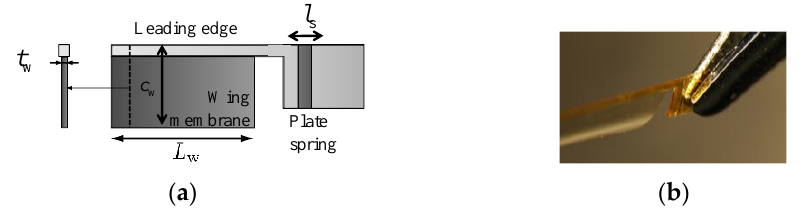
Figure 12. Detailed view of the 2.5-dimensional wing: ( a ) In-plane view and the dimensional parameters; ( b ) an example of prototyping of this wing using the micromachining technique. In this example, the wing chord length is c w = 2.8 mm.